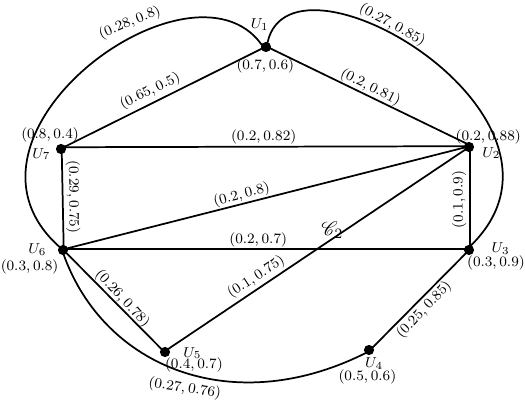
Figure 19. Pythagorean fuzzy electric connection model. Figure 7.2: Pythagorean fuzzy electric connection model